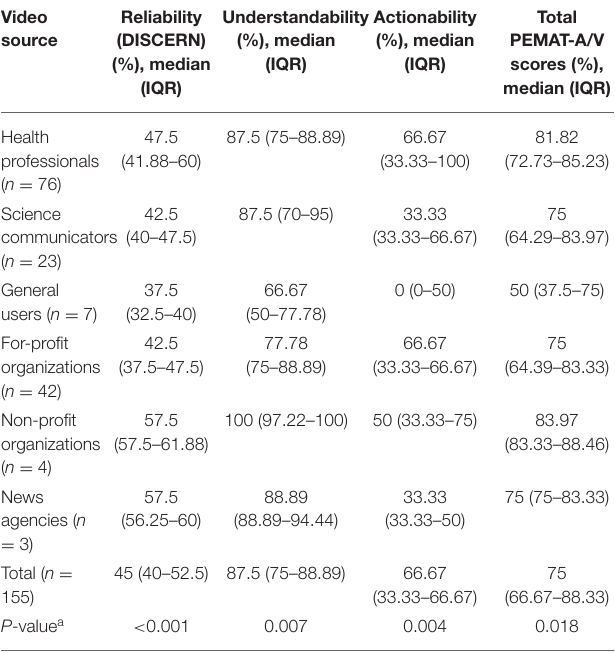
TABLE 2 | DISCERN and PEMAT-A/V scores of diabetes-related TikTok videos by source. Video